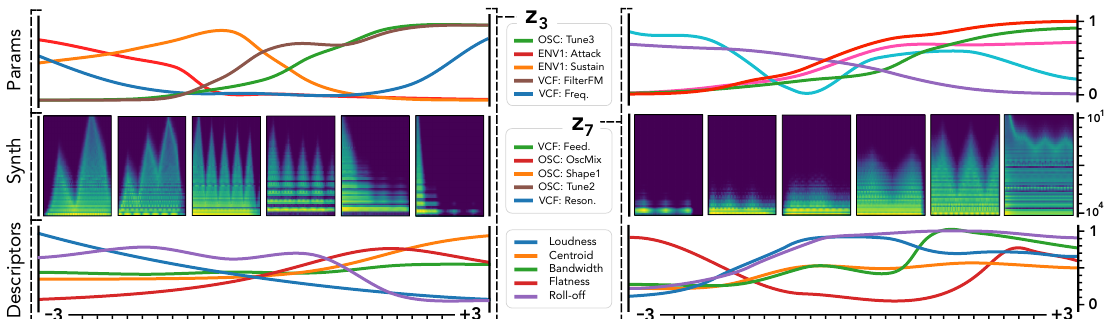
Figure 5. Macro-parameters learning . We show two of the learned latent dimensions z and compute z ) when traversing these dimensions, while keeping all other fixed at 0 to see how the mapping p ( v | z define smooth macro-parameters. We plot the evolution of the 5 parameters with highest variance ( top ), the corresponding synthesis ( middle ), and audio descriptors ( bottom ). ( Left ) z 3 seems to relate to a percussivity parameter. ( Right ) z 7 defines a form of harmonic densification